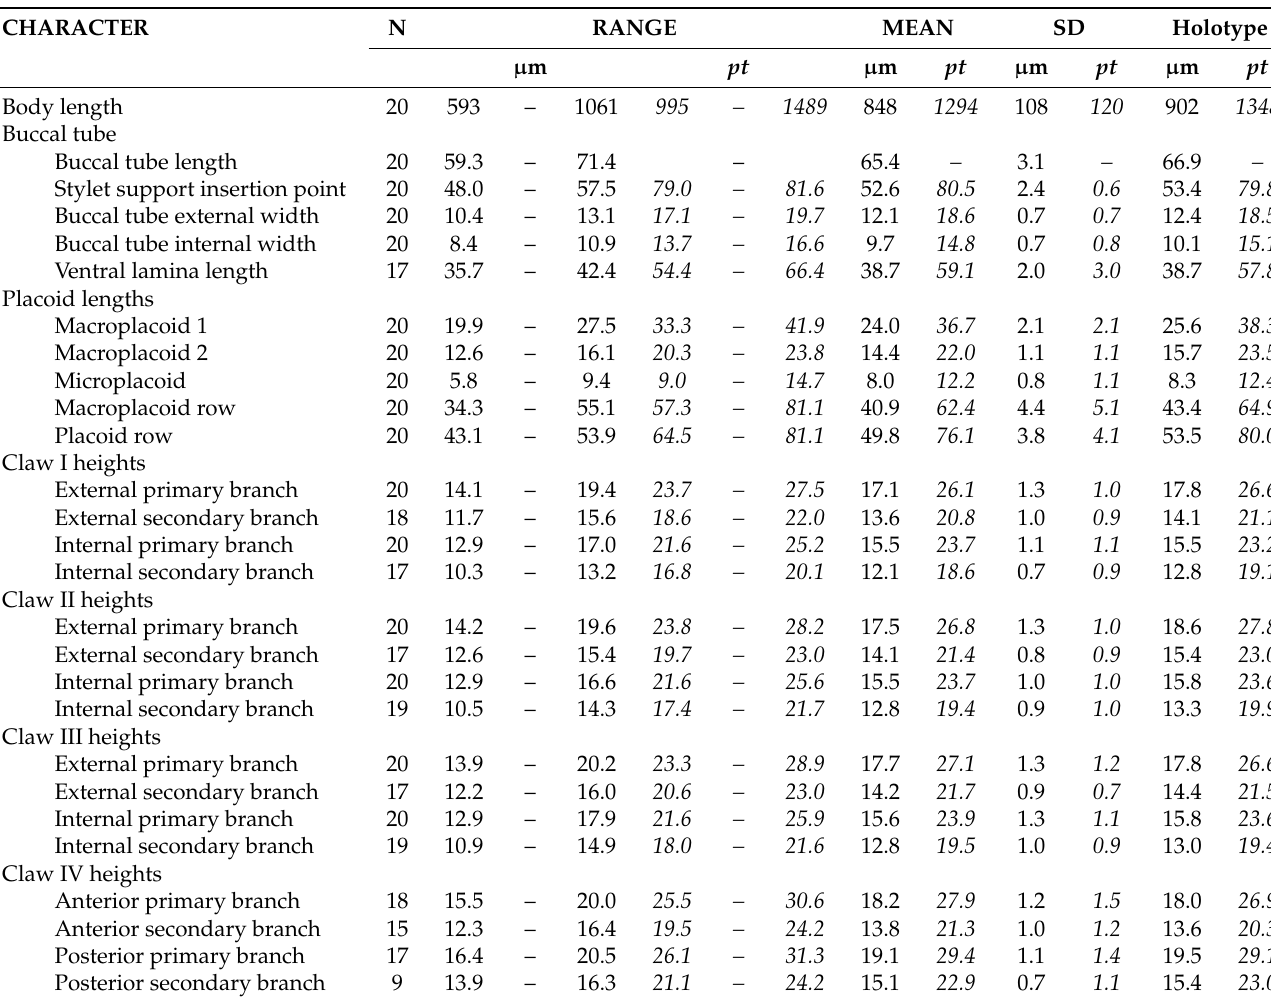
Table 2. Measurements (in µ m) and pt values of selected morphological structures of animals of Macro- biotus rebecchii sp. nov.; specimens mounted in Hoyer’s medium; N—number of specimen/structures measured. Range refers to the smallest and the largest structure among all measured specimens; SD—standard deviation.